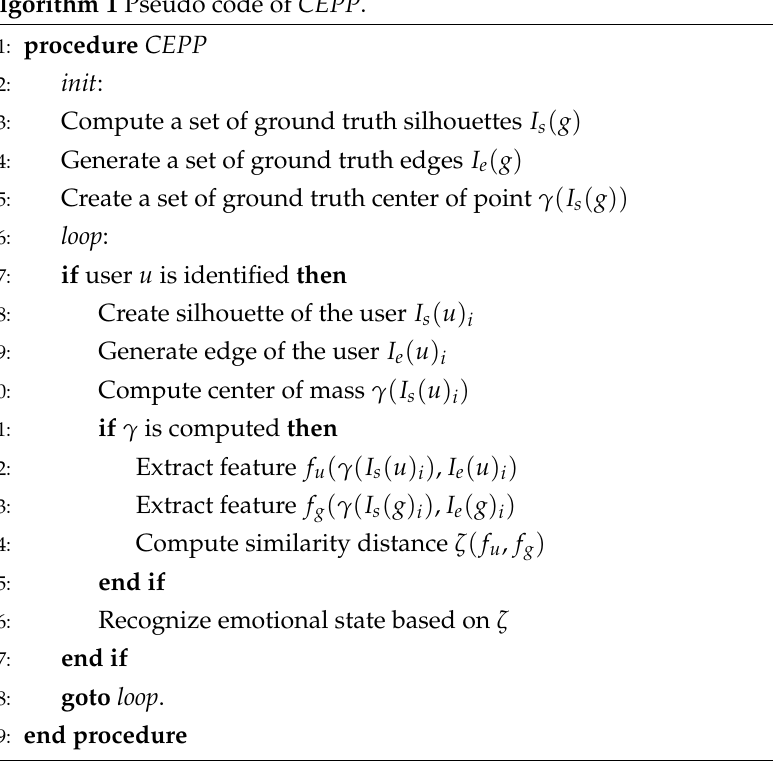
Algorithm 1 Pseudo code of CEPP